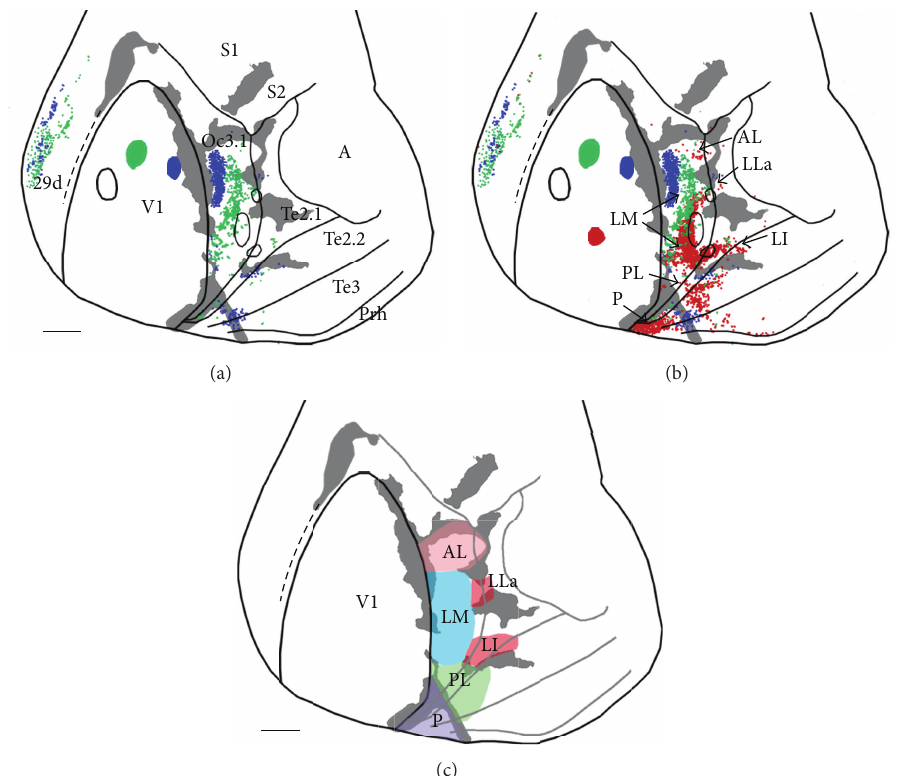
Figure 5: Data from case 86-21. (a) Labeling pattern following a mediolateral sequence of tritiated proline (black outlines), GB (green), and FB (blue) injections across V1. Callosal connections are indicated in grey. (b) Addition of a posterior injection of RB (red) illustrates the labeling pattern resulting from an anteroposterior sequence of injections. Arrows indicate tentative visual areas. (c) Summary of tentative visual areas identified from this case. AL: anterolateral, LM: lateromedial, PL: posterolateral, P: posterior, LLa: laterolateral anterior, and LI: laterointermediate. Scale bars = 2 mm.